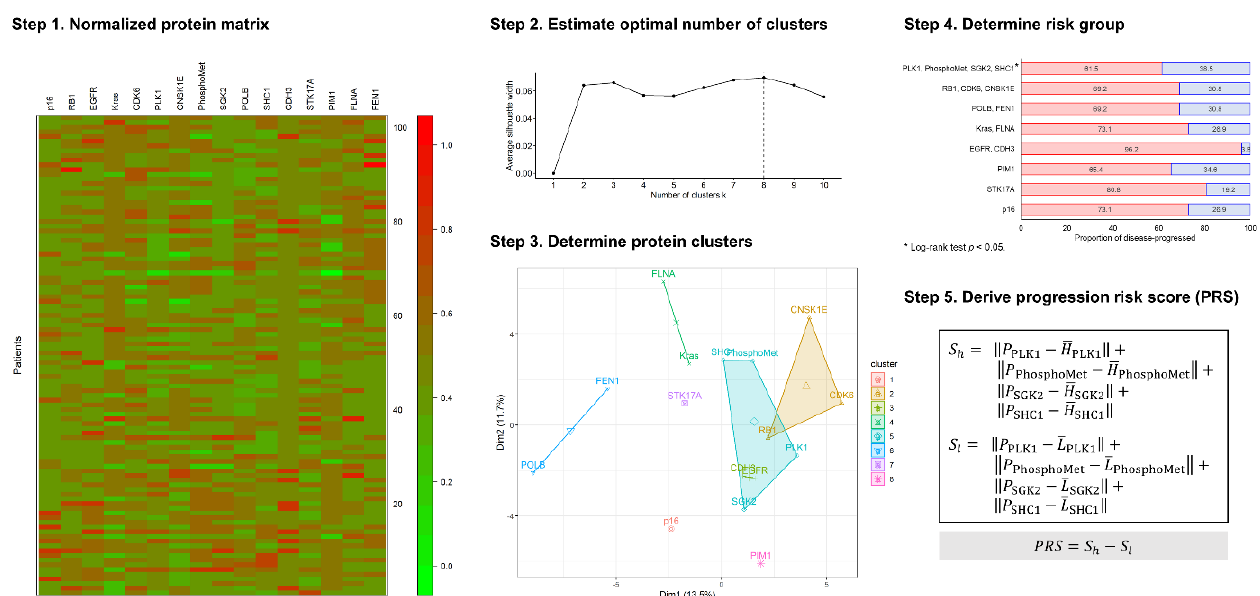
Figure 2. The analysis workflow for the protein staining matrix of target genes. (Step 1) Normalized the protein matrix of 16 individual cytoplasmic IHCs. (Step 2) Estimate the optimal number of clusters according to silhouette index. (Step 3) Determine protein clusters using the optimal number of clusters. (Step 4) Dichotomized and determined risk group according to the proportion of disease progression of each protein cluster. (Step 5) Derived progression risk score (PRS) using immunostaining score of the specific target protein within specific cluster, and the harmonic mean of the immunostaining score in correspond risk group.